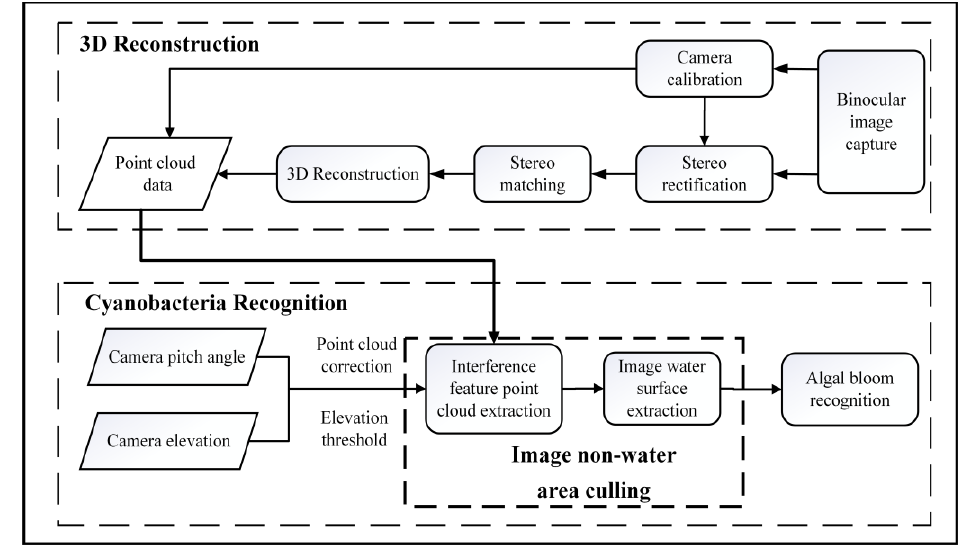
Figure 4. Flowchart of the proposed accurate extraction method for algal